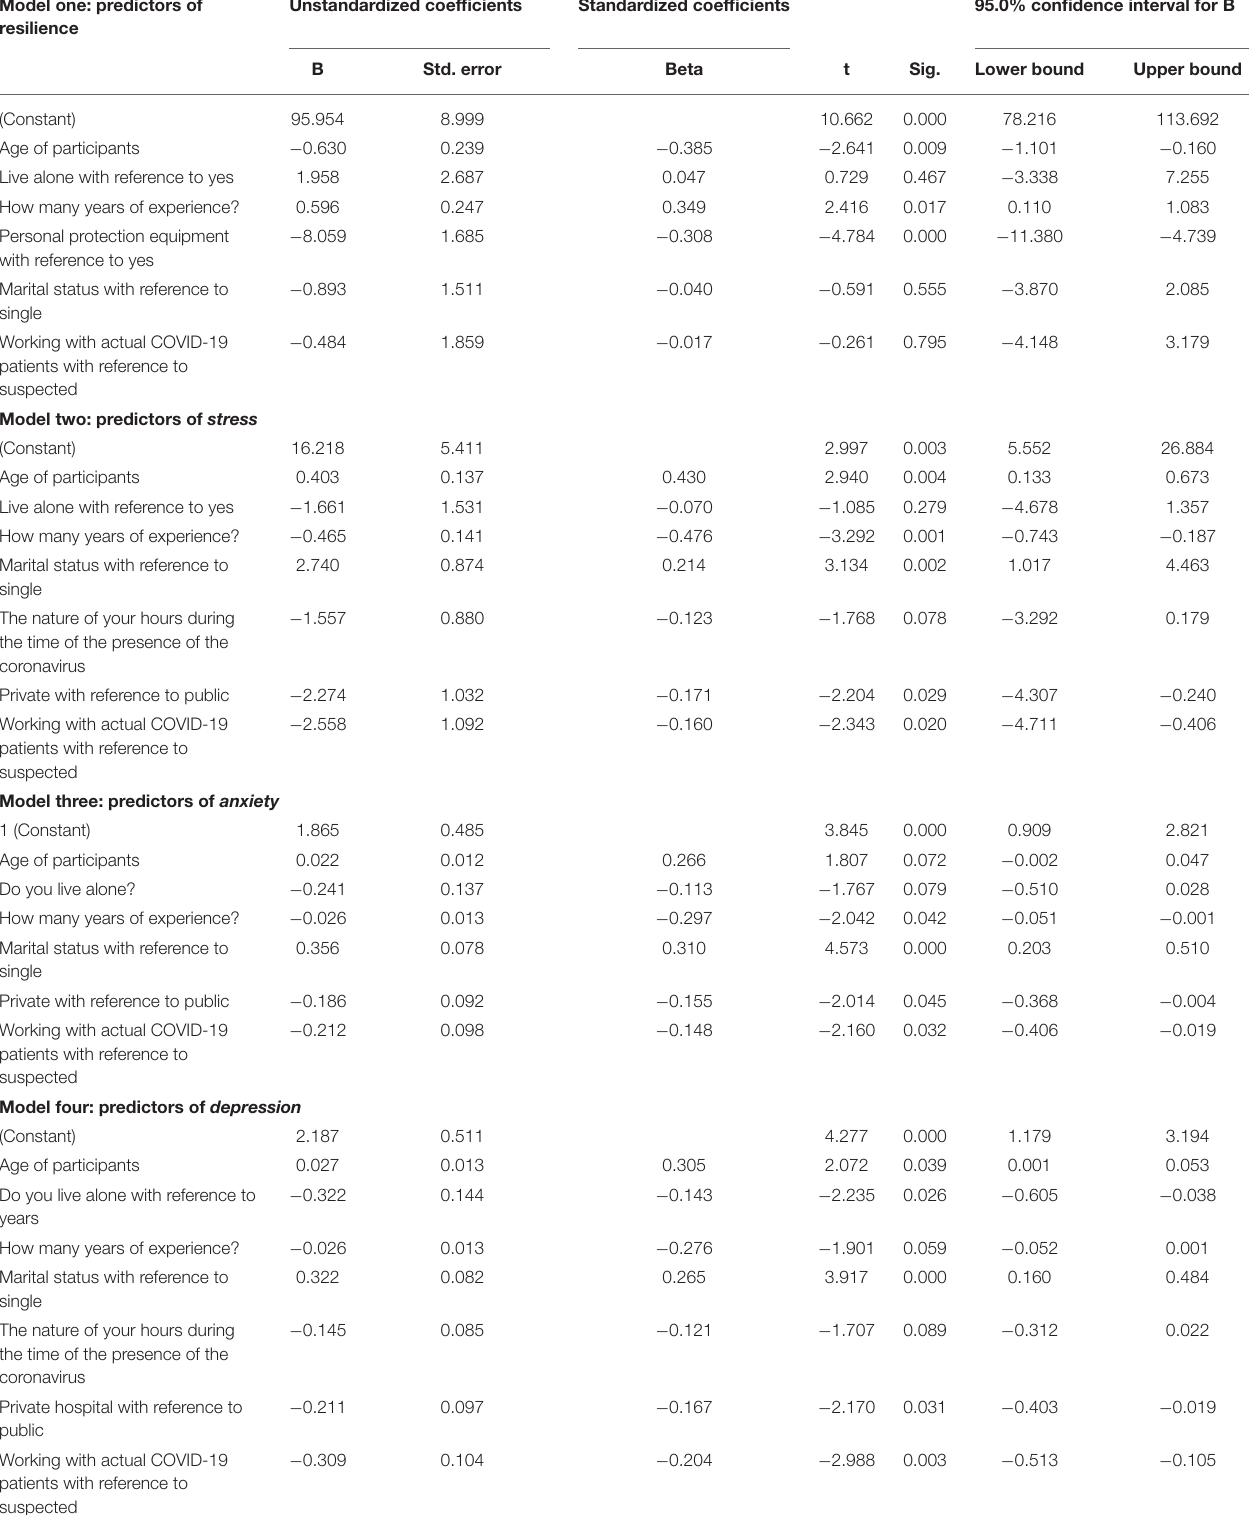
Table 5 | Predictors of resilience, stress, anxiety, and depression. Model one: predictors of